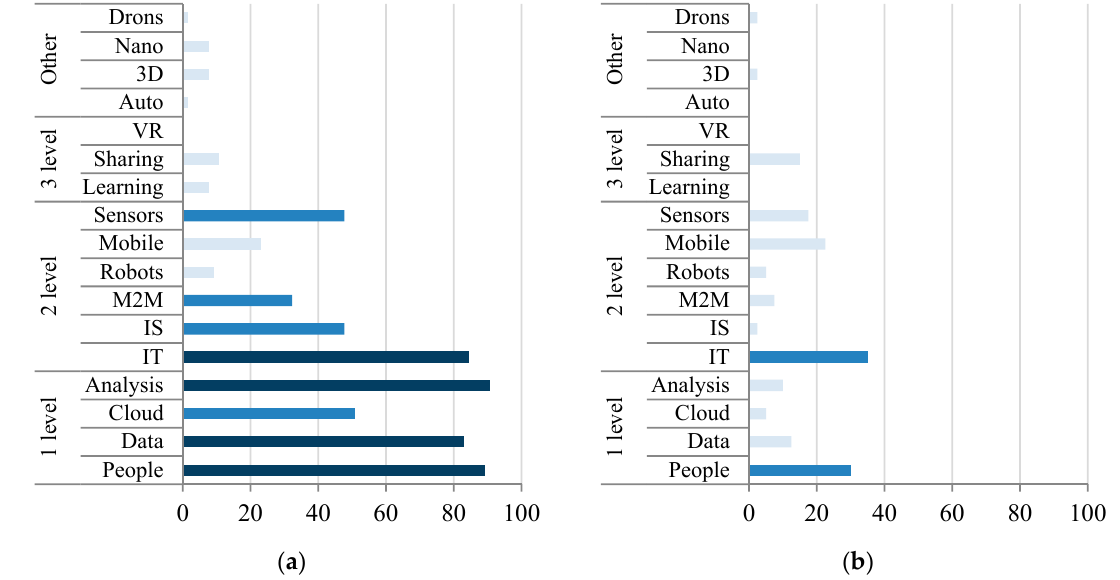
Figure 6. Clusters characteristics: ( a ) Cluster 3—I4 starting enterprises; ( b ) Cluster 4—I4 noobs enterprises.